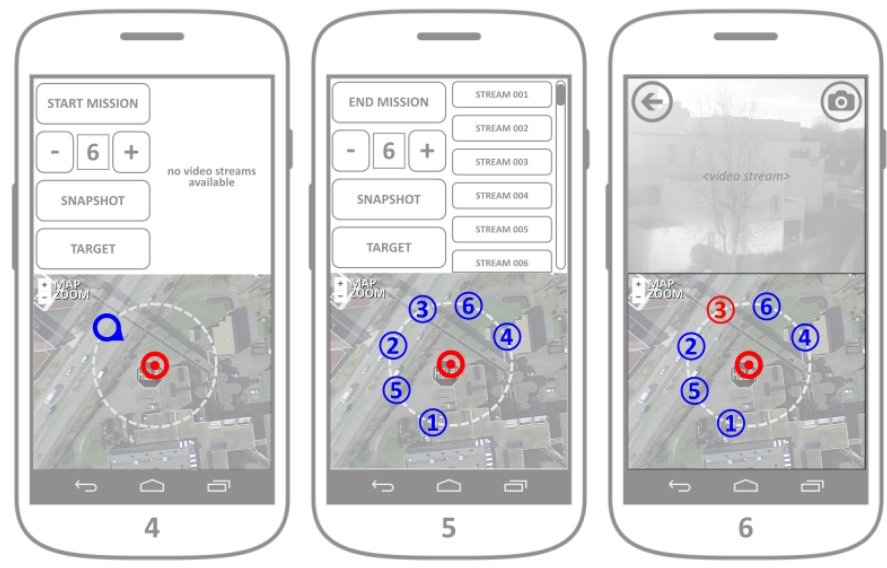
Figure 11. Fleet control